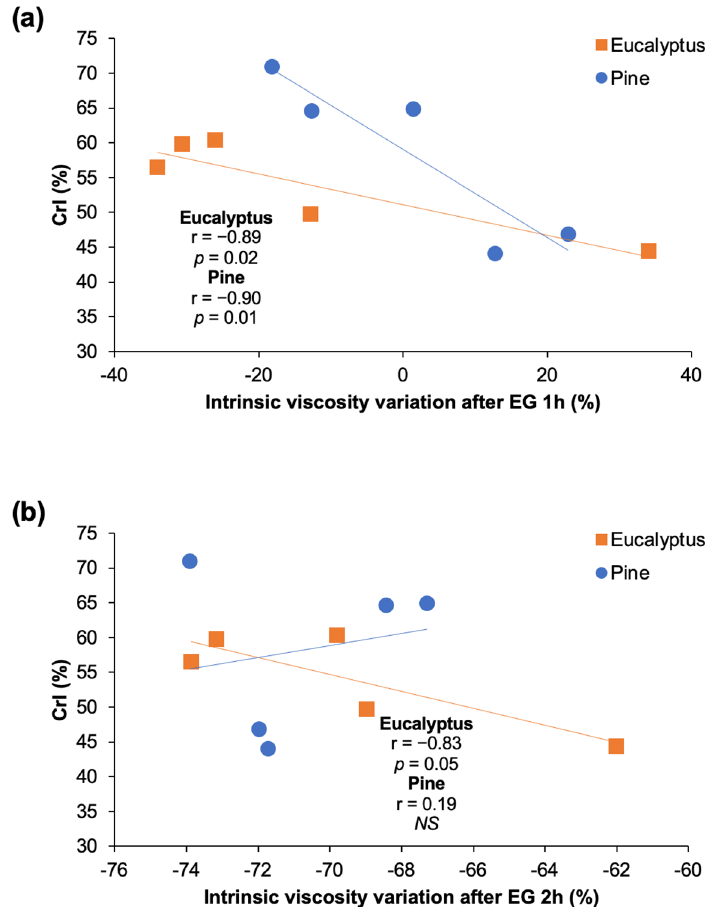
Figure 11. Regression lines and Pearson correlation indexes (r) of crystallinity degree vs. variation of the intrinsic viscosity after EG treatment of eucalyptus and pine pulps for ( a ) 1 h and ( b ) 2 h. Correlations were considered significant at p value < 0.05. NS: not significant.